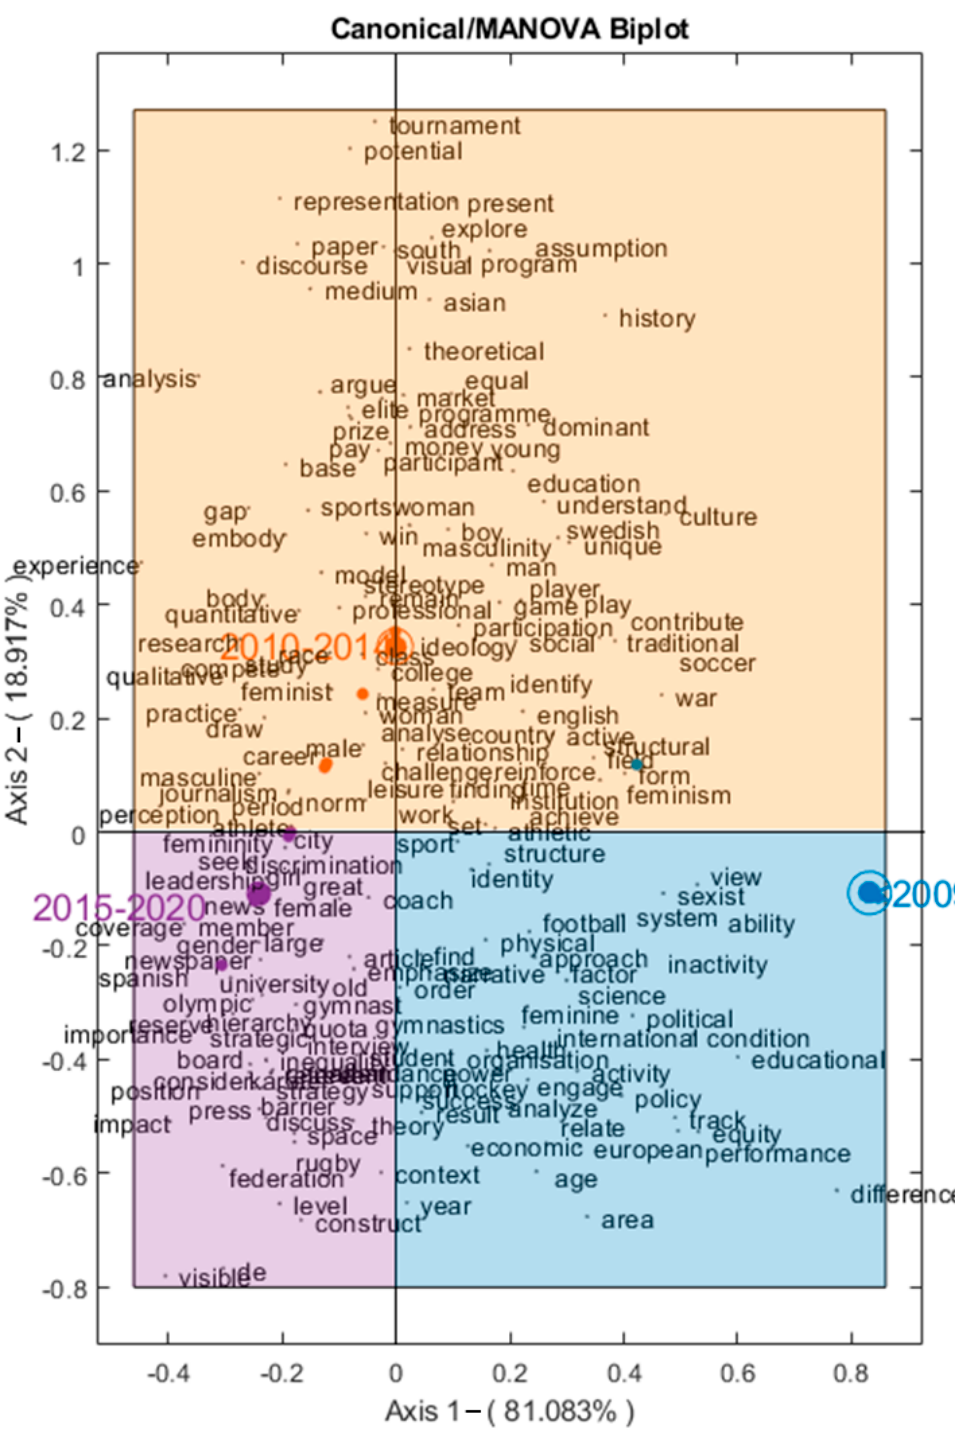
Figure 7. Thematic areas identified by the MANOVA Biplot for the SLR of inequalities in women’s sport. In the same way, if we analyze the results obtained from the MANOVA Biplot analysis applied to the lexical table from the SRL on the professionalization of women’s sport, we can identify two major thematic blocks that classify the articles. The two predefined groups served to show a change in the trend in scientific publications. This change took place in 2010. Although the differences are not marked in the analysis of inequalities, there are significant differences between the publications that appeared before 2010 (third and fourth quadrants), and those that appeared onward from that